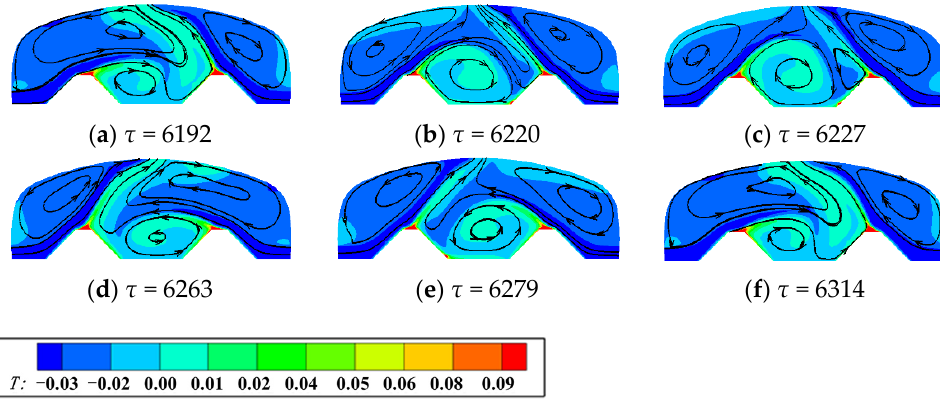
Figure 5. Evolution of isotherms and streamlines in a period for Re = 7.67 × 10 6 .